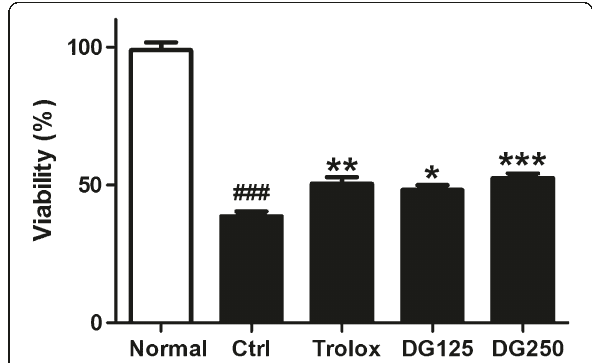
Figure 2 The protection of DG against hypoxia and reoxygenation (H/R)-induced injury in H9c2 cells. After 12 h of hypoxia, the solution was changed into a normal medium with or without DG (125 and 250 μ g/ml) or trolox (20 μ M) in the 4 hours reoxygenation period. Cell viability was then measured by MTT assay. The data were expressed as mean ± S.E.M. Six replicates were done in each experiment. Three independent experiments were performed. *p < 0.05, **p < 0.01 and ***p < 0.001 indicated the groups with significant difference when compared to the control group; ### p < 0.001 when compared to the normoxic